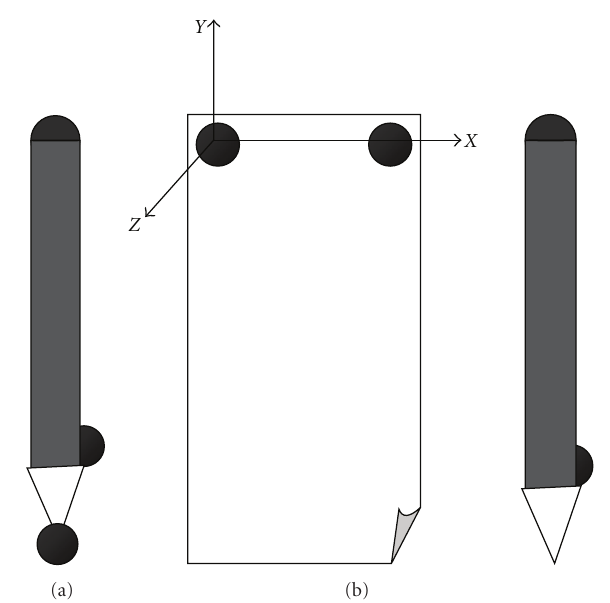
Figure 1: (a) Position of the markers for the static acquisition. (b) Position of the markers for the dynamic